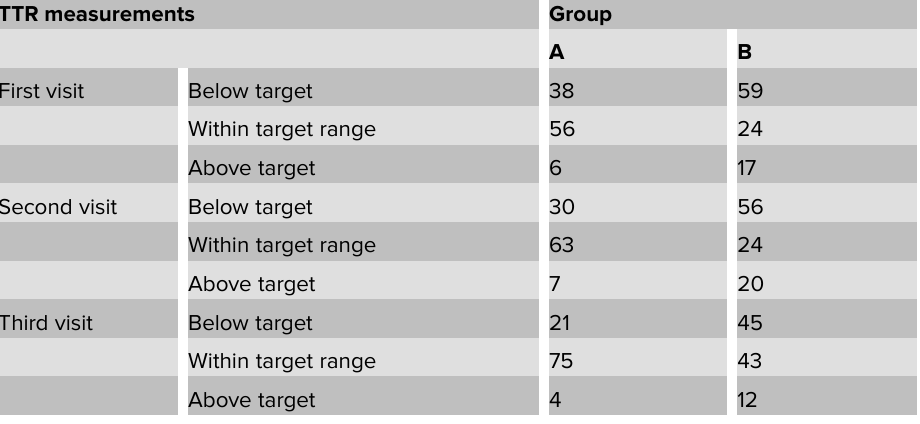
Table 3: Time in therapeutic range (TTR) measurements in INR-C (group A) and General-C (group